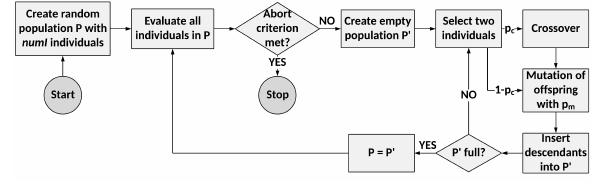
Figure 4. Process of optimisation with GA (according to (Boersch et al., 2007)).